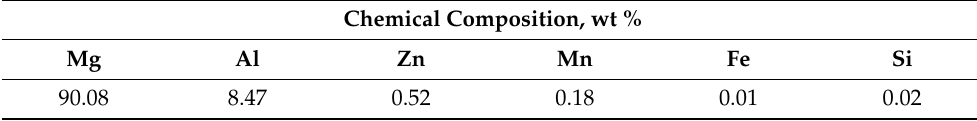
Table 1. The chemical composition of the baseline magnesium alloy